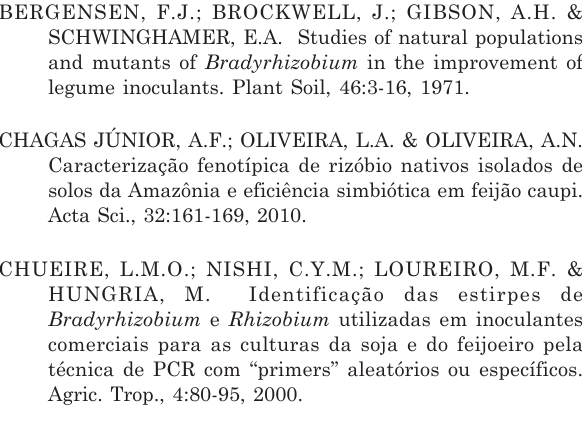
*Values compared to the mineral-N treated plants with Hoagland and Arnon solution (1950) containing 210 mg N, 14 mg as NH 4+